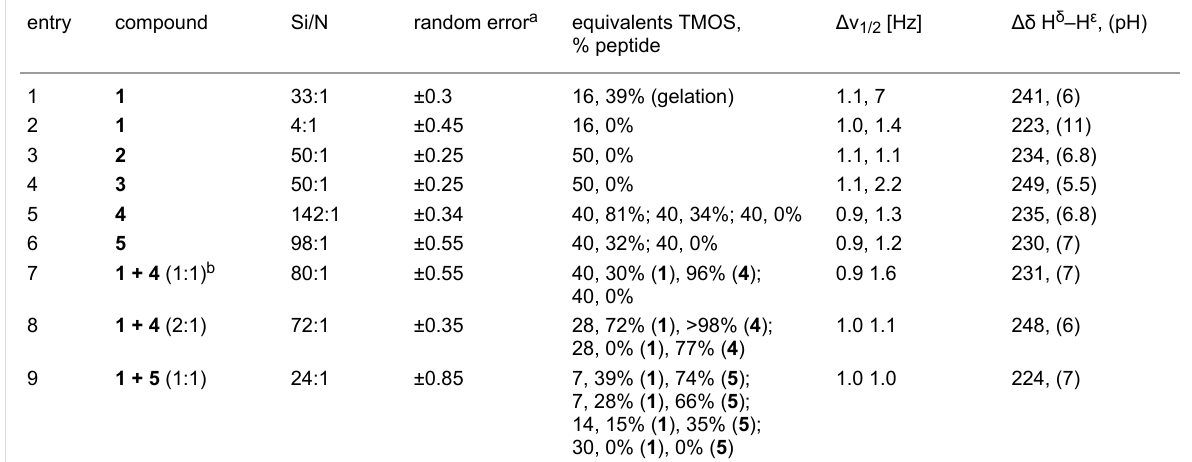
Table 1: Silica precipitation experiments. The final column is the initial splitting of the imidazole signals which correlates with the observed pH value in brackets. The lower three rows list the numerical values for the bar diagrams in Figure 6.